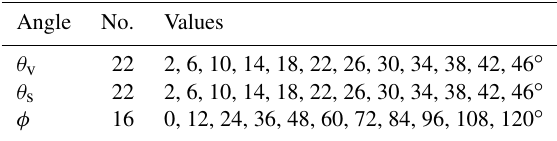
Table 2. Solar and viewing geometries simulated by AFRT. Each identified view zenith, θ v ; solar zenith, θ s ; and relative (solar minus observation) azimuth, φ , angle value is simulated, for a total of 7744 (22 × 22 × 16) combinations.